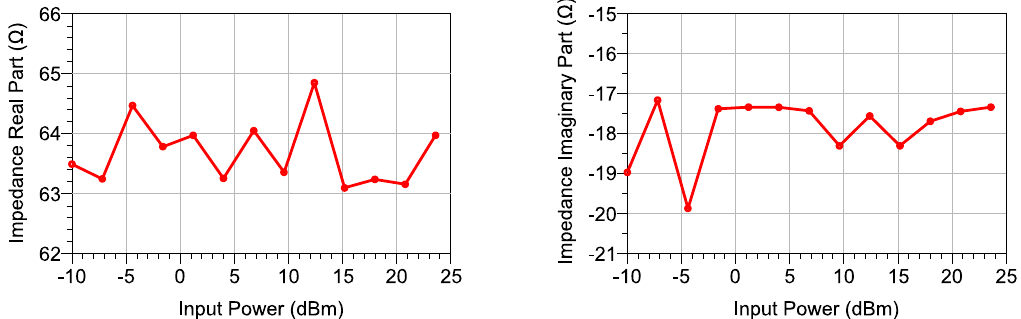
Figure 15. Real and imaginary part of a detected impedance as a function of the input power at 5.5 GHz.